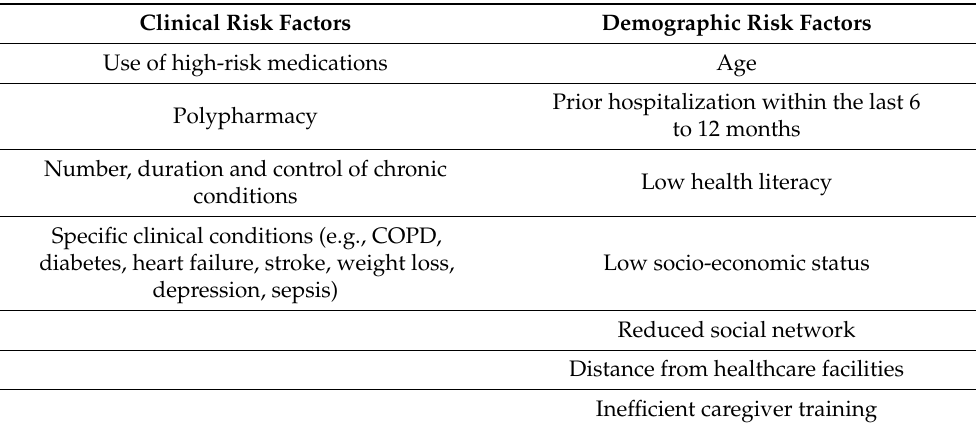
Table 1. Clinical and demographic risk factors of